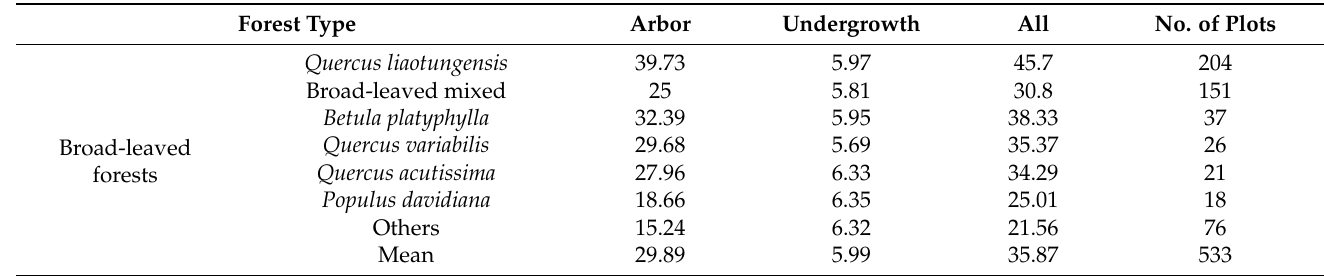
Table 2. The arbor, undergrowth, and total biomass carbon density for natural broad-leaved and coniferous forests in Shanxi,